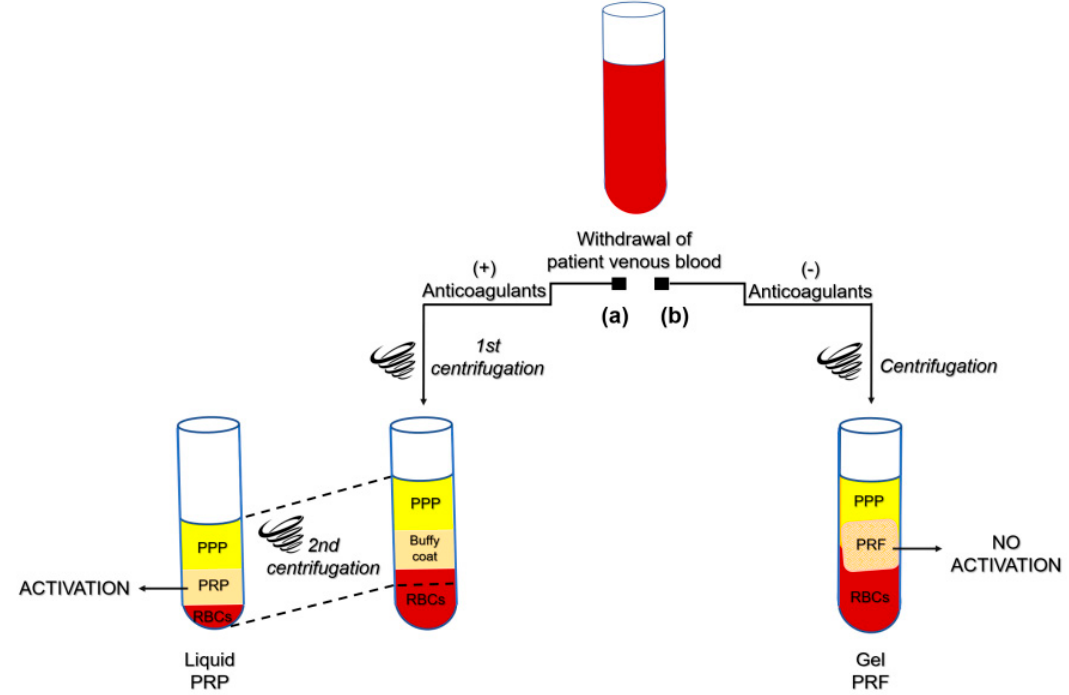
Figure 1. Platelet concentrates preparation protocols. Schematic drawing of the classical preparation protocols of PRP (Platelet Rich Plasma) and PRF (Platelet Rich Fibrin) hemocomponents. According